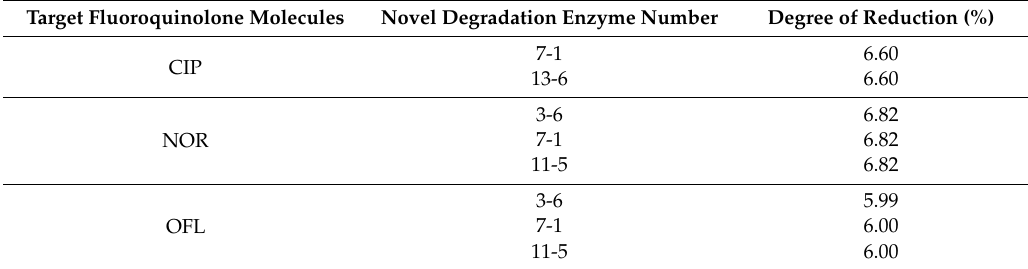
Table5. Degradationbarriersbetweennoveldegradationenzymesanddi ff erenttargetfluoroquinolones. Target Fluoroquinolone Molecules